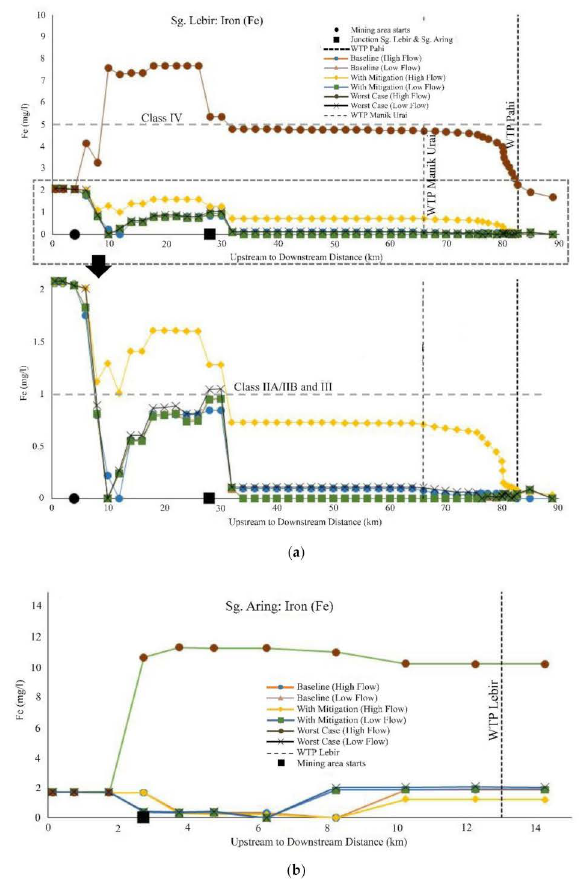
Figure 7. ( a , b ) showing Fe concentration in different scenarios for Sungai Lebir and Sungai Aring, respectively.